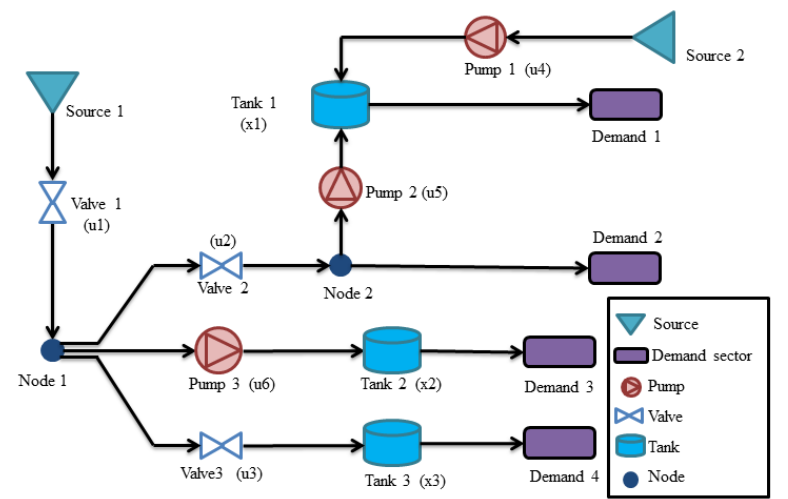
Figure 2. Drinking water network diagram